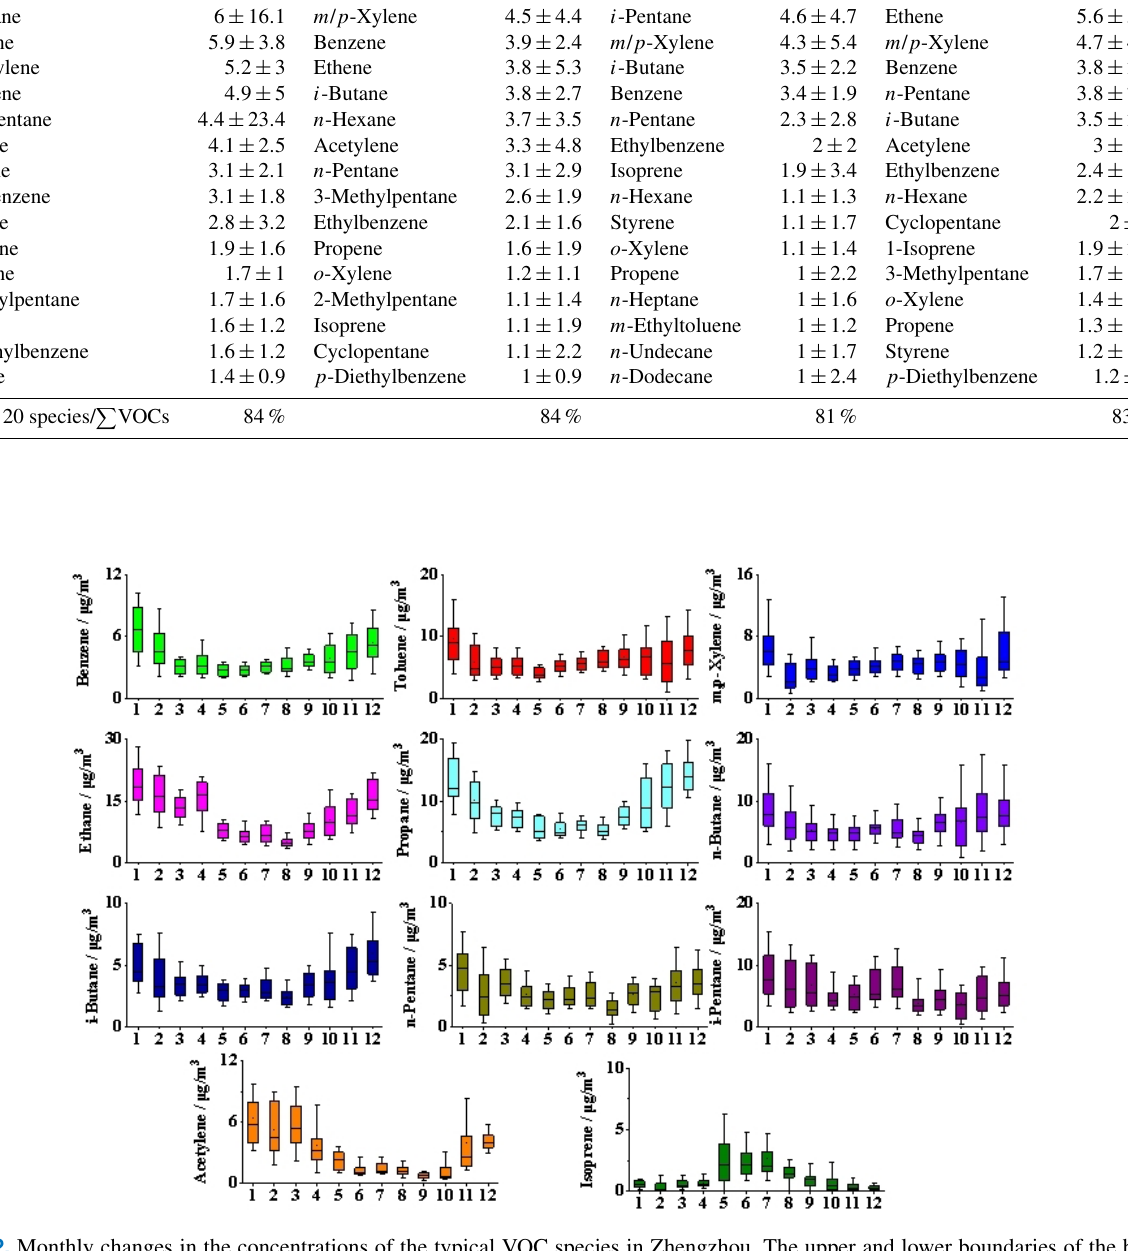
Figure 2. Monthly changes in the concentrations of the typical VOC species in Zhengzhou. The upper and lower boundaries of the boxes indicate the 75th and 25th percentiles, respectively; the lines within the boxes mark the median; the whiskers above and below the boxes indicate the 90th and 10th percentiles,